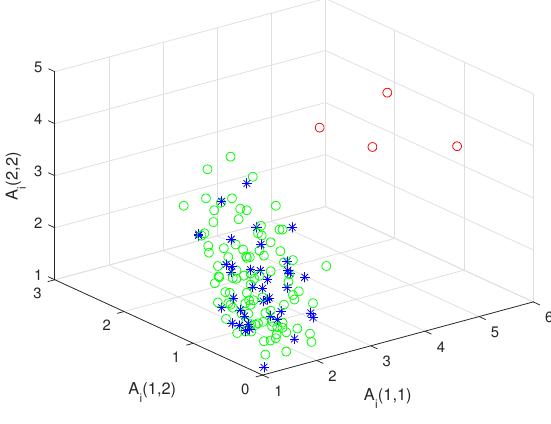
Figure 7. Target